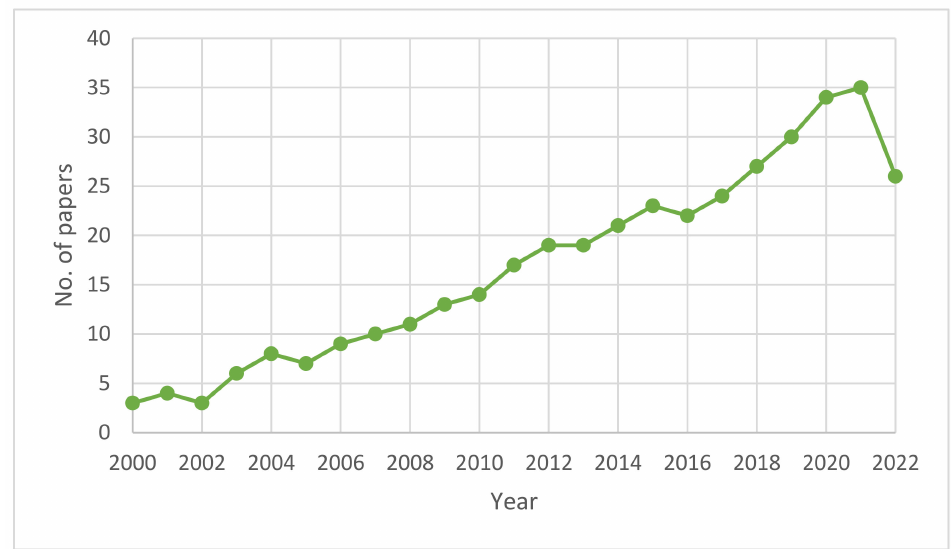
Figure 4. Trends of published papers in the selected fields of the study.